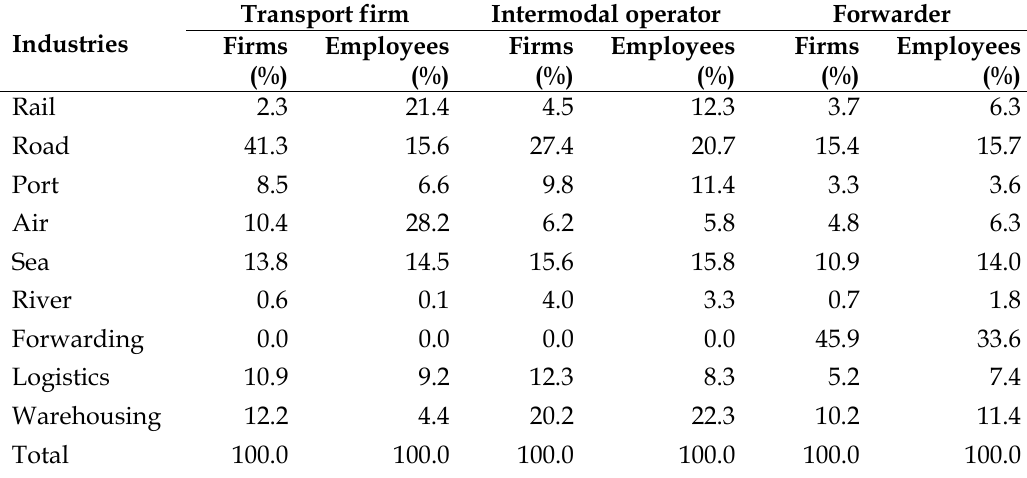
Table 4. Distribution of firms by main industries Transport firm